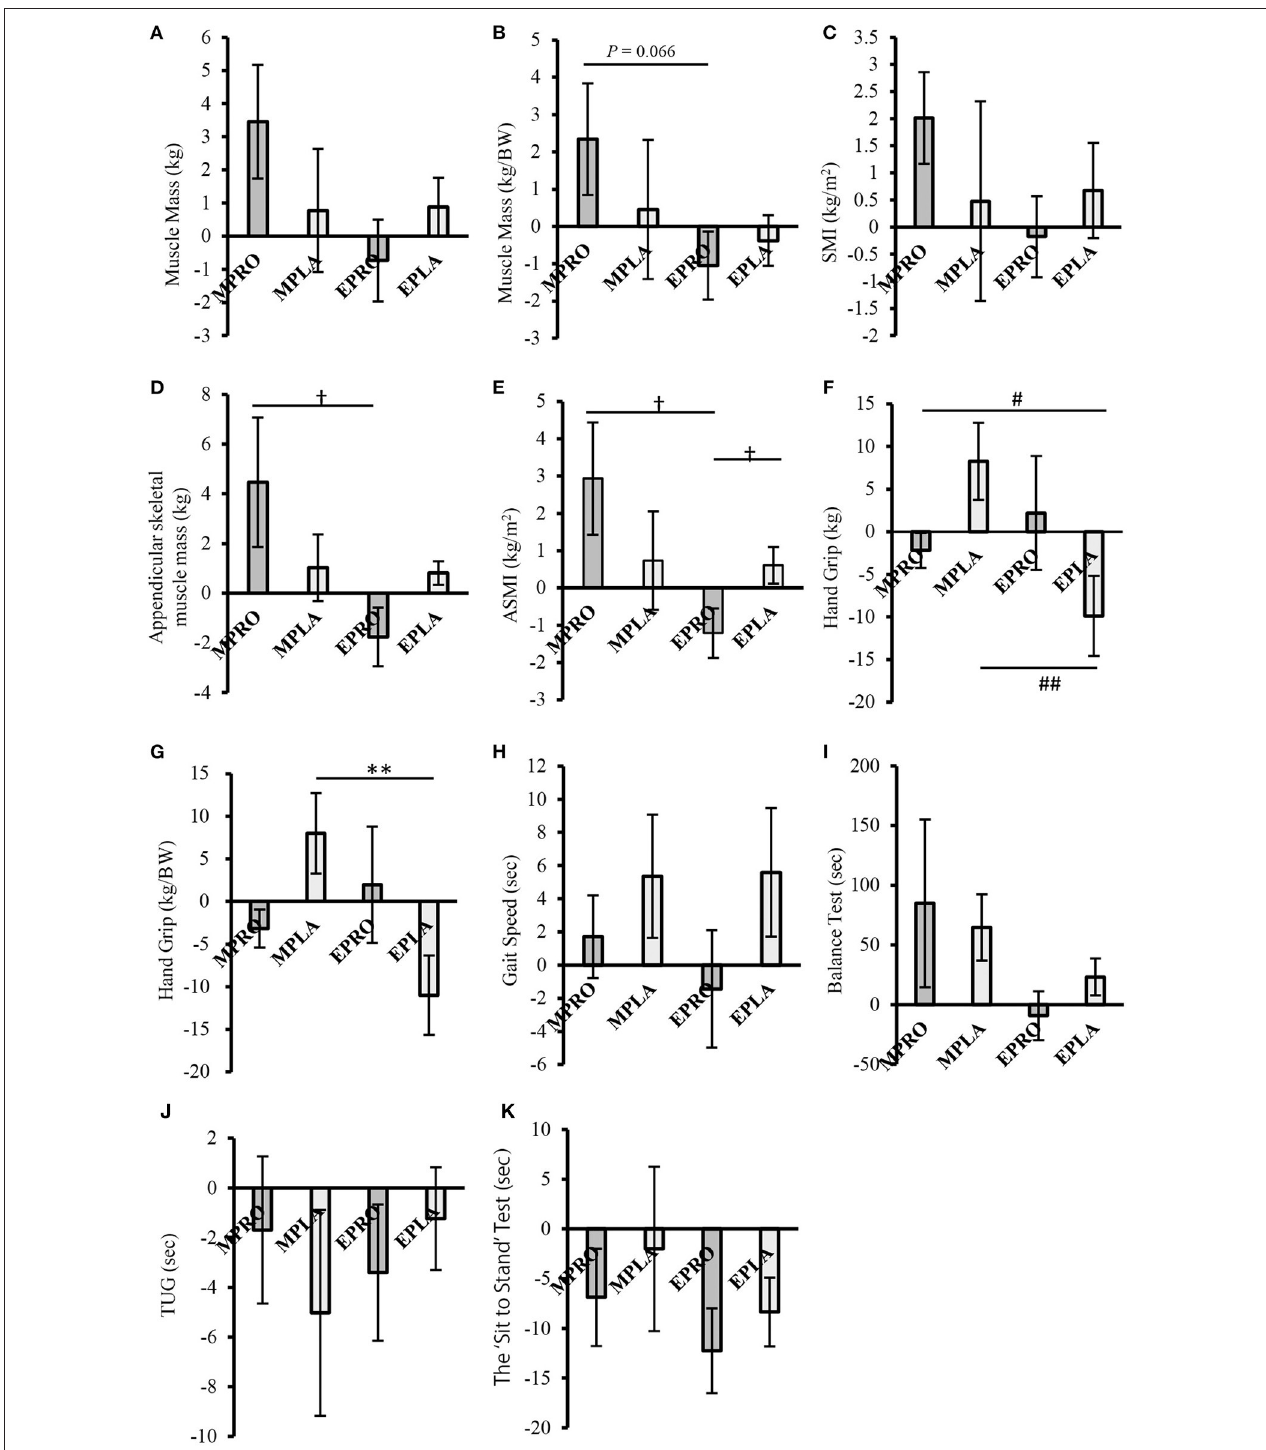
FIGURE 6 | Comparison of the rate of change of sarcopenia-related factors by intervention (intervention study) (A) Muscle mass, (B) Muscle mass (weight-corrected), (C) SMI, (D) Appendicular skeletal muscle mass, (E) ASMI, (F) Handgrip strength, (G) Handgrip strength (weight-corrected), (H) Gait speed, (I) One-leg stand test, (J) TUG, (K) The “Sit to Stand” Test. Values are expressed as the mean ± standard error. † P < 0.05, compared to EPRO (Mann-Whitney). # P < 0.05, ## P < 0.01, compared to EPLA (Mann-Whitney). ** P < 0.01 compared to EPRO (Two-Way ANOVA). MPRO, morning protein intake group; MPLA, morning placebo intake group; EPRO, evening protein intake group; EPLA, evening placebo intake group; BW, body weight; SMI, skeletal muscle index; ASMI, appendicular skeletal muscle index; TUG, time up and go.